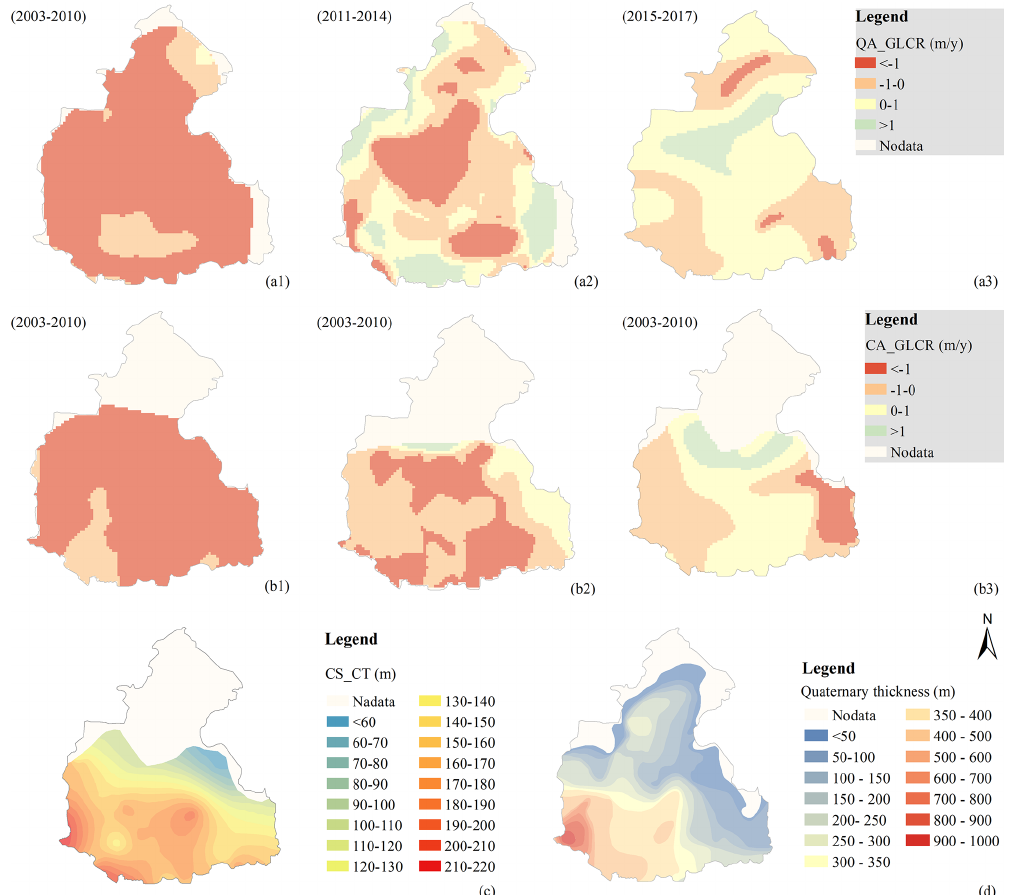
Figure 5. Assessment factors: (a1–a3) annual rate of groundwater level change in the unconfined aquifer (QA_GLCR) over the three peri- ods 2003–2010, 2011–2014, and 2015–2017, respectively. Negative values mean lowering; (b1–b3) annual rate of groundwater level change in the confined aquifer system (CA_GLCR) over the three periods 2003–2010, 2011–2014, and 2015–2017, respectively. Negative values mean lowering; (c) cumulative thickness of compressible sediments (CS_CT); (d) Quaternary